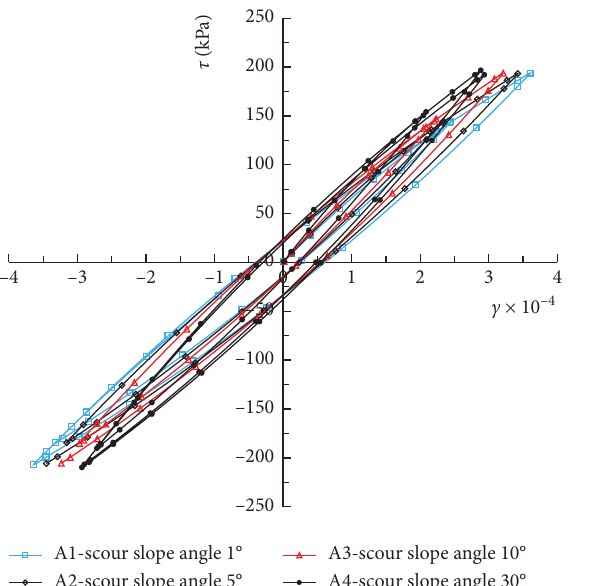
Figure 12: Stress-strain hysteresis loops of the surface soil under different scour slope